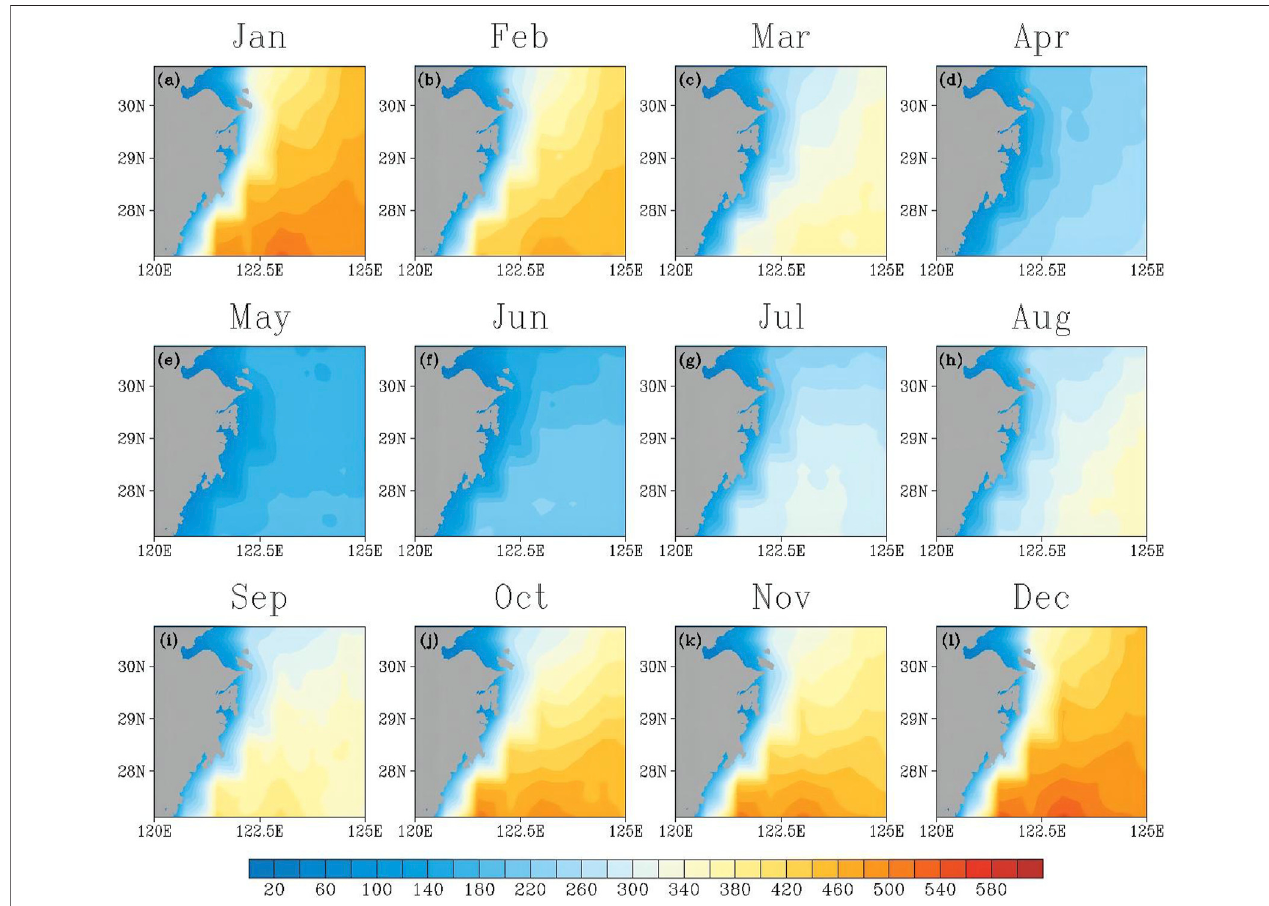
FIGURE 6 | The monthly climate average of Zhejiang coastal wind energy resource (units:w · m − 2 ). (a-l) represent January to December respectively.